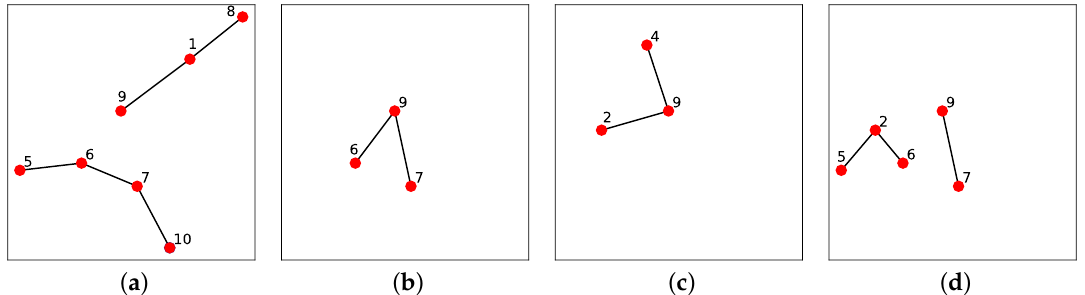
Figure 5. A sequence of four random simplicial complexes K 1 , K 2 , K 3 and K 4 is displayed in ( a – d ), respectively. Each 0-simplex [ v i ] is represented by a red dot and labelled with its corresponding index i . Each 1-simplex is represented by a black line segment joining the corresponding two 0-simplex faces. The positioning of each simplicial complex was determined using the force-directed graph drawing algorithm [23].